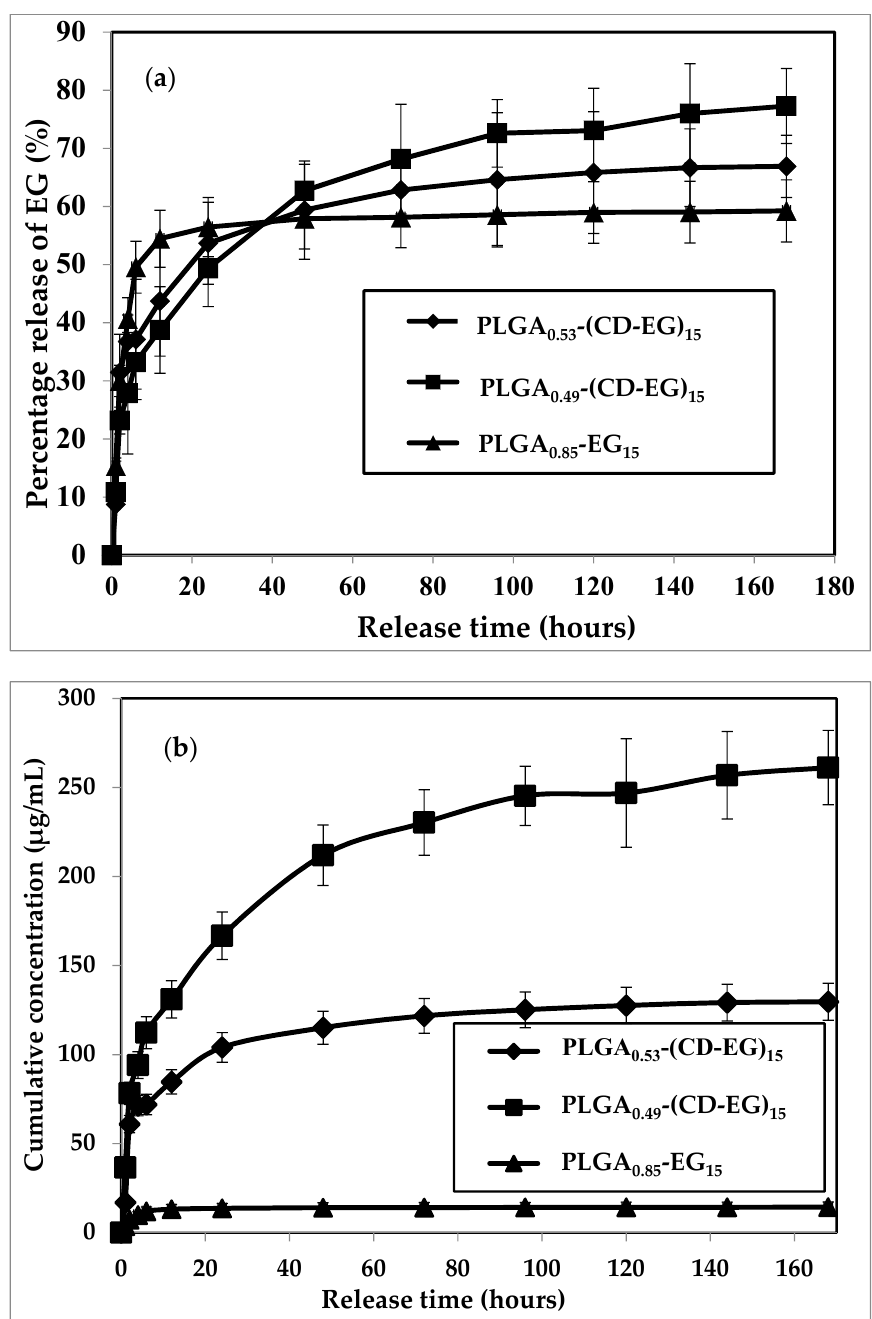
Figure 5. Profiles of percentage release ( a ) and cumulative concentration ( b ) of EG from various PLGA microspheres in PBS (pH = 7.4, 37 °C, shaking speed at 500 rpm).